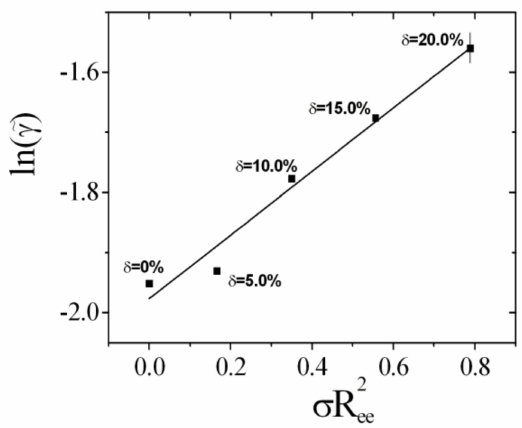
Figure 5. The logarithm of the minimum surfactant amount (cid:101) γ for di ff erent fractions of Comb 4 as a function of the scaled polymer surface density σ R 2 ee . The rightmost data point indicates the typical error